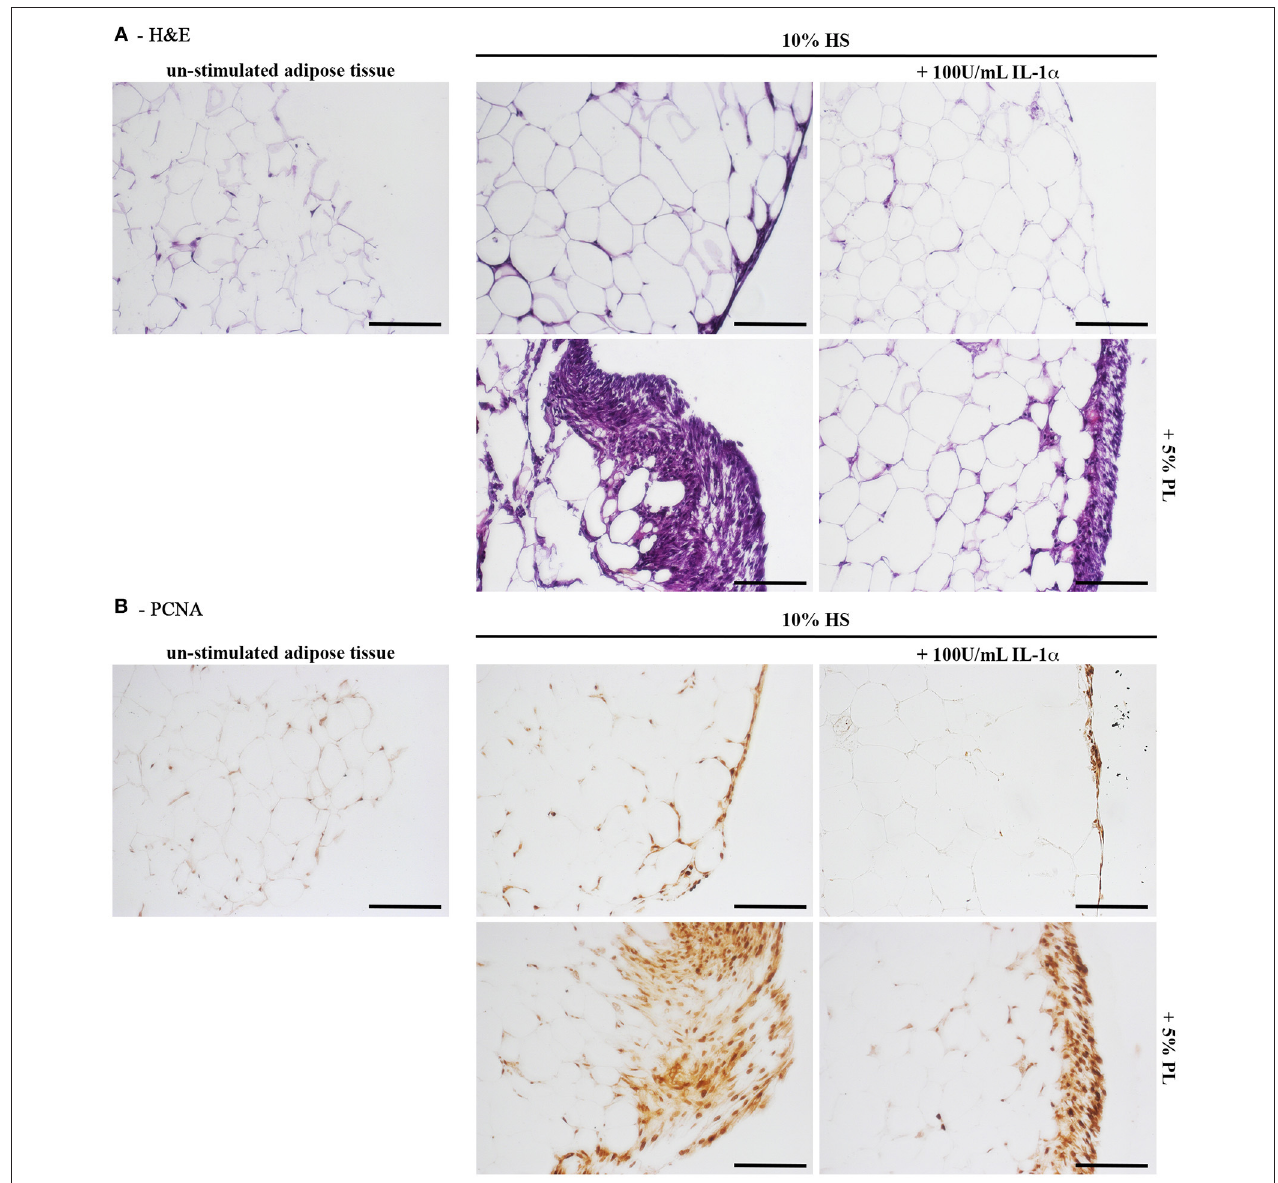
FIGURE 8 | Histology of in toto hAT samples cultured ex vivo using medium containing HS without any other supplement or supplemented with 5% PL, 100 U/mL IL-1 α , or 5% PL + 100 U/mL IL-1 α , for 14 days. “Un-stimulated adipose tissue” refers to hAT samples paraffin-embedded immediately after their isolation from the resection material and not cultured. (A) Hematoxylin and Eosin staining of paraffin-embedded hAT cross sections (scale bars = 150 µ m); (B) Immunohistochemistry of paraffin-embedded hAT cross sections with a specific primary antibody raised against the nuclear proliferation marker PCNA (scale bars = 150 µ